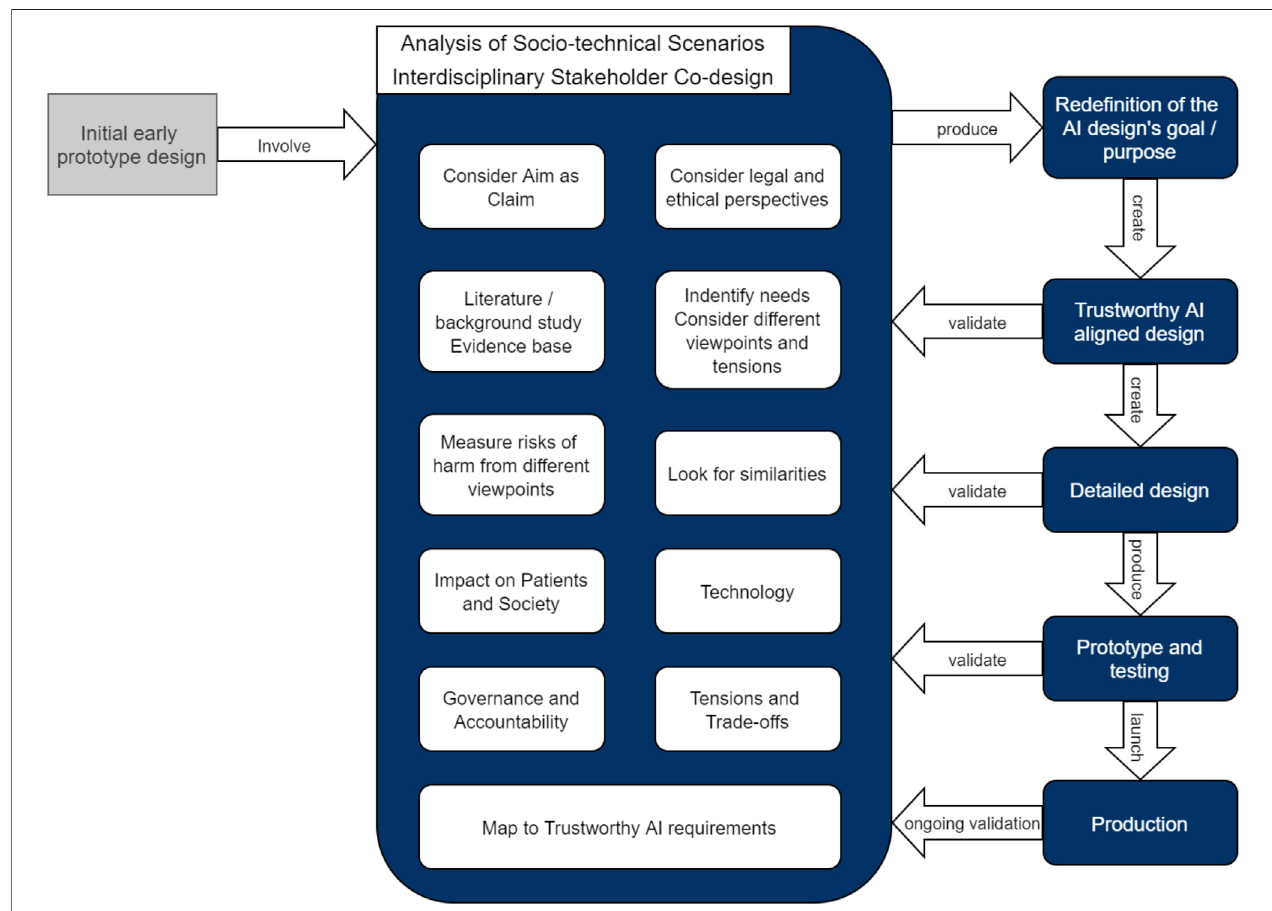
FIGURE 1 | Co-design Framework for Deep Learning based Skin Lesion Classi fi er.